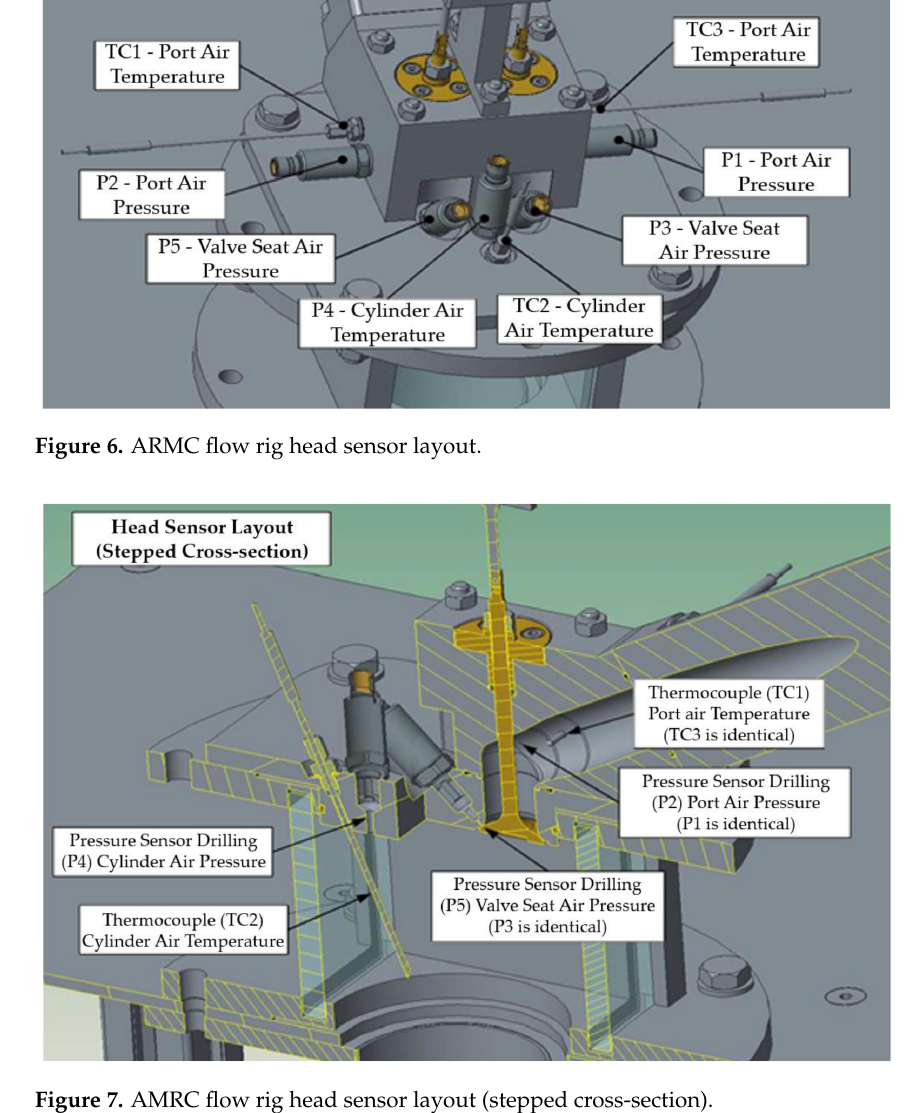
Figure 7. AMRC flow rig head sensor layout (stepped